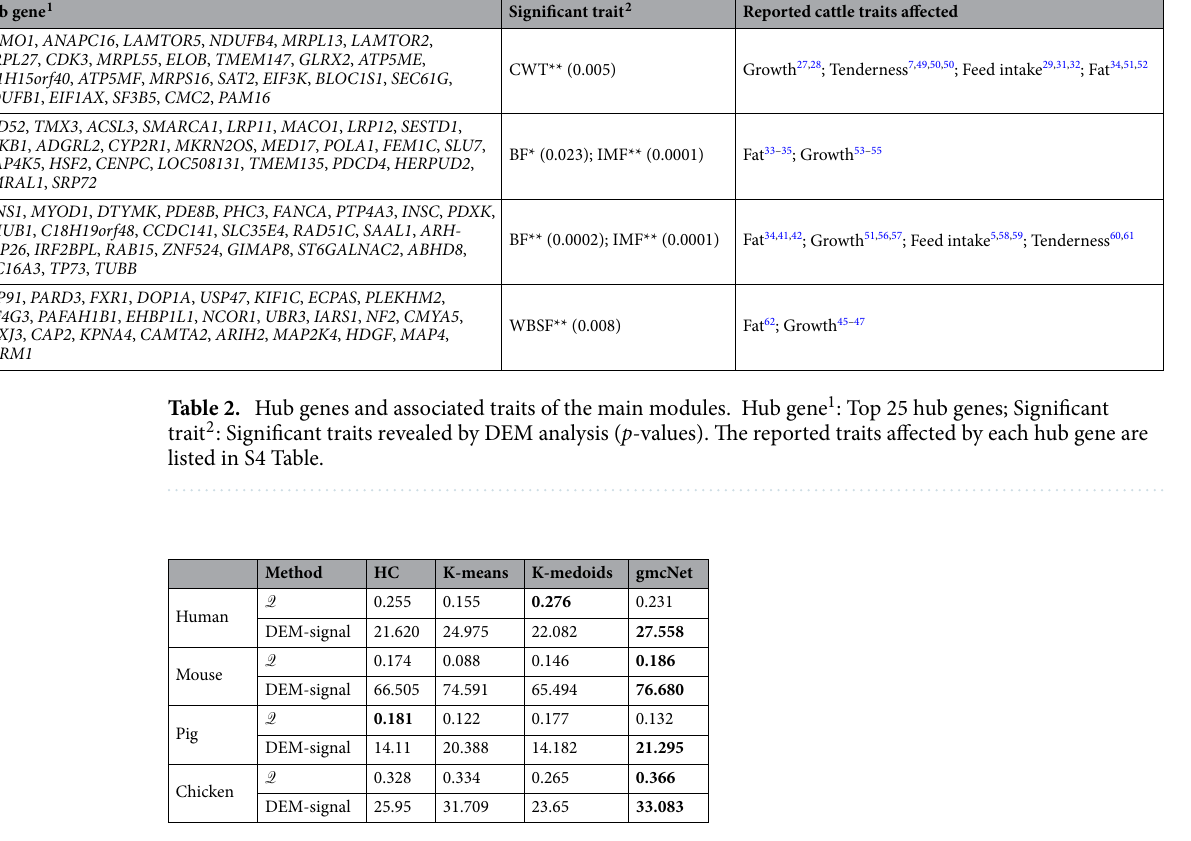
Table 3. Model performance on GEO dataset in terms of graph modularity Q and DEM signaling. Significant values are in